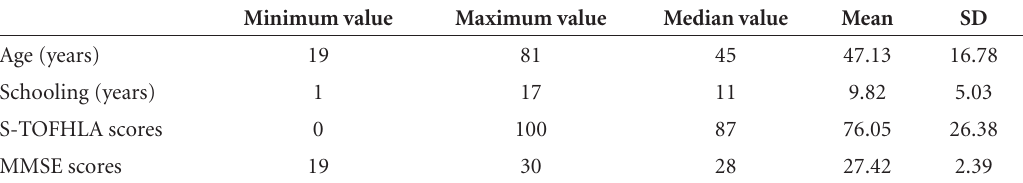
Table 1. Demographics, S-TOFHLA and MMSE scores.